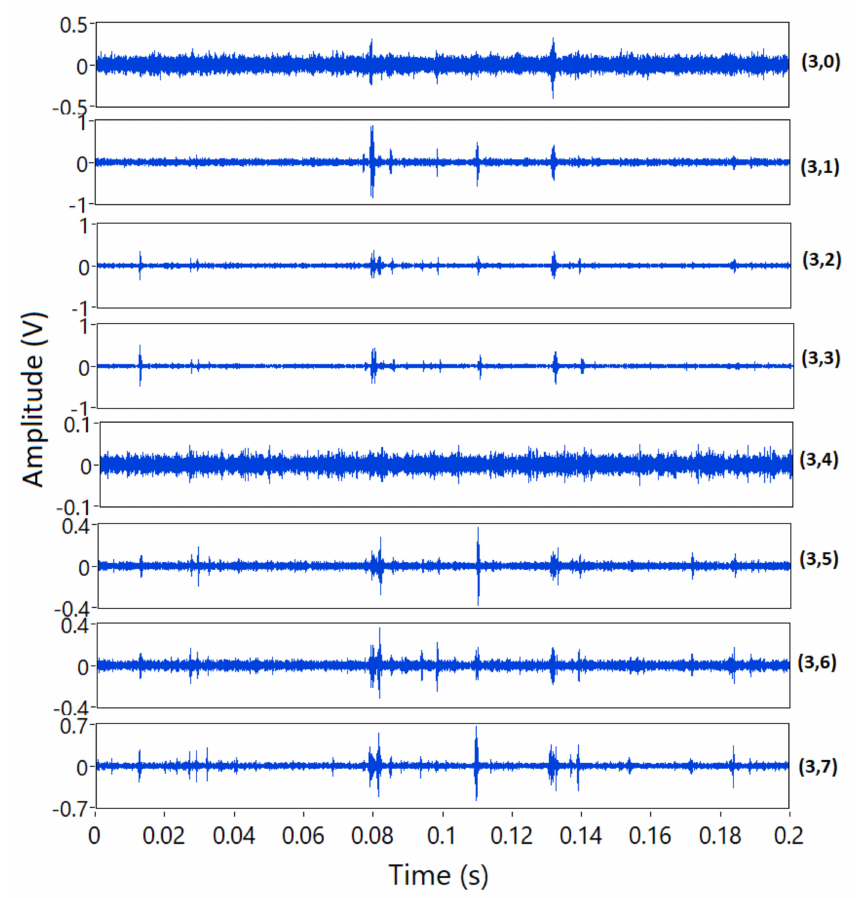
Figure 9. The eight nodes of the AE signal extracted from WPT 3-level